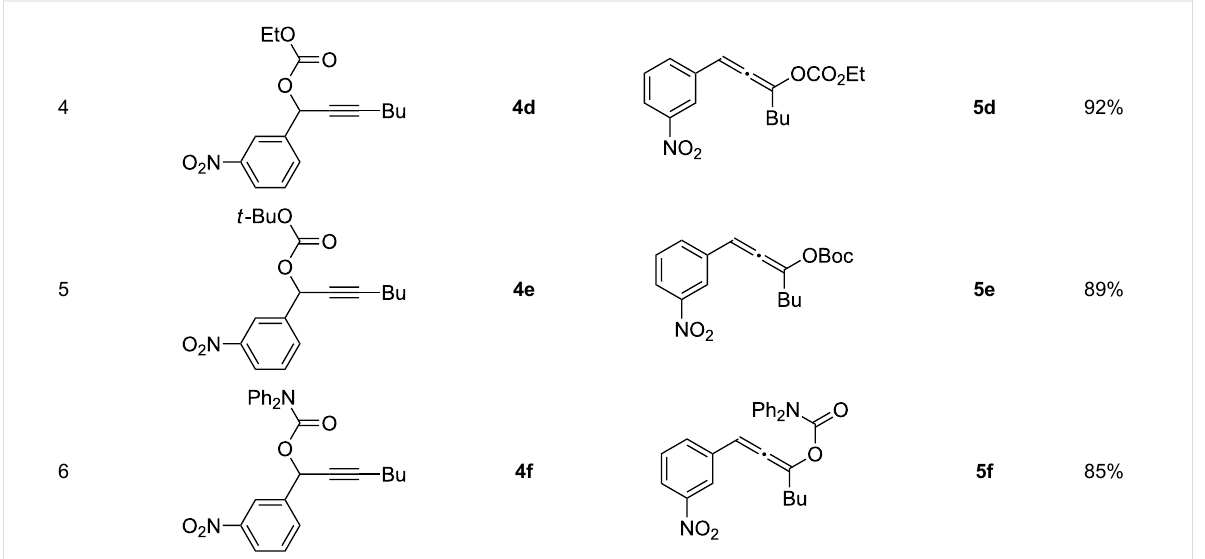
Table 2: Different migrating groups. a